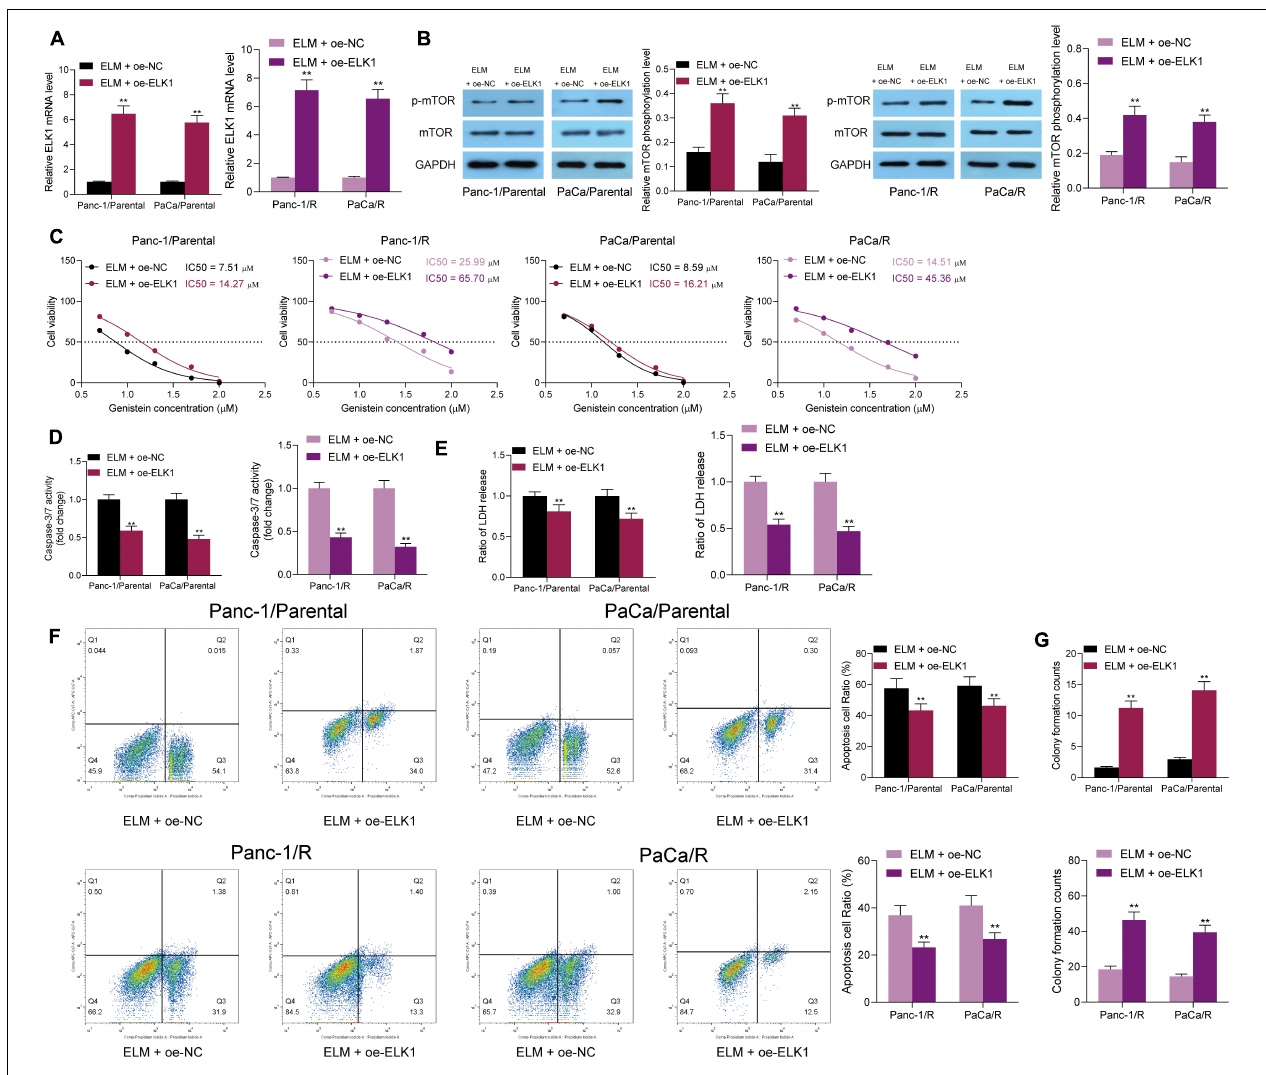
FIGURE 7 | Downregulation of ELK1 blocks the promoting role of ELM in the genistein-sensitivity in PC cells. (A) Expression of ELK1 in PC cells after ELK1 interventions detected by RT-qPCR. (B) mTOR phosphorylation in cells determined by Western blot analysis. (C) IC50 of genistein in cells evaluated by a CTG kit. (D) Activity of caspase-3/7 in cells examined by a caspase-3 kit. (E) Lactate dehydrogenase (LDH) release in cells measured using an LDH release kit. (F) Apoptosis rate in PC cells assessed using flow cytometry. (G) Viability of cells evaluated using the colony formation assay. Data were collected from three independent experiments and presented as mean ± SD. ** p <